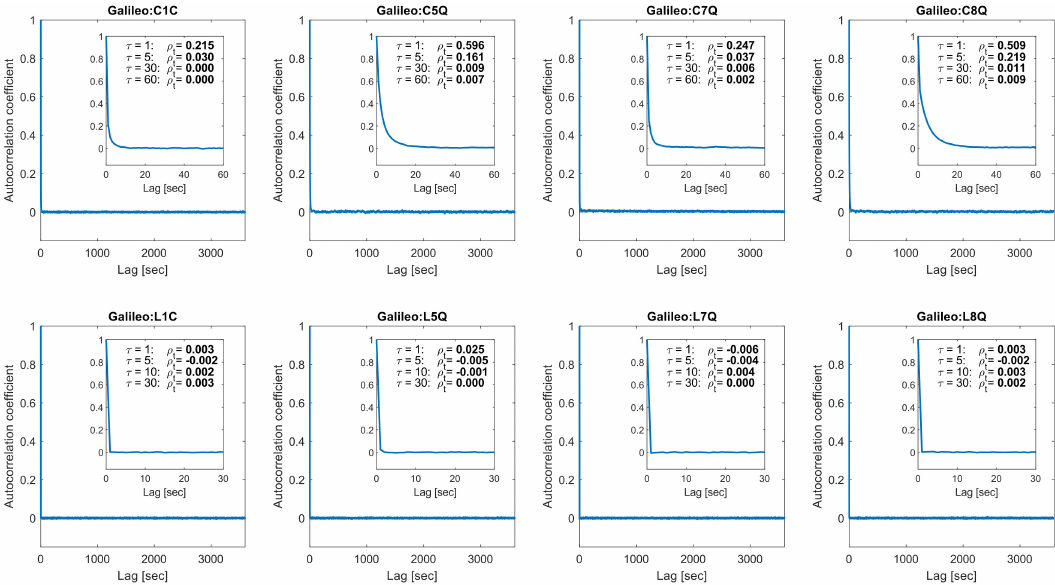
Figure 6. Sample autocorrelation coefficients for Galileo observations (2019 DOY: